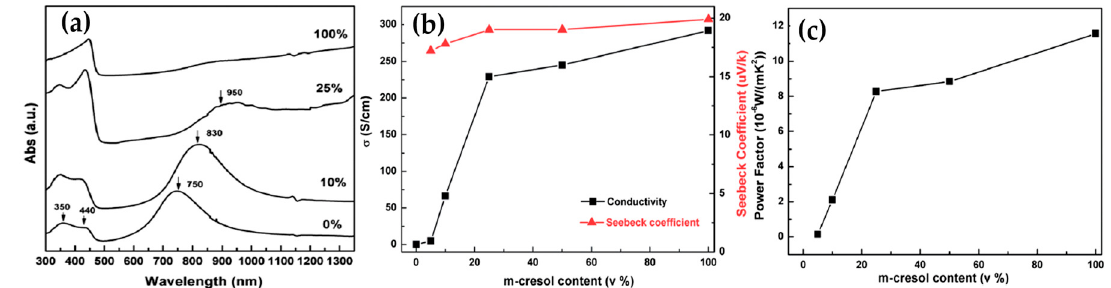
Figure 1. ( a ) The ultraviolet ‐ visible (UV ‐ vis) spectra of polyaniline (PANi) dissolved in different m ‐ cresol contents, ( b ) the electrical conductivity and Seebeck coefficient, and ( c ) the power factor of the polyaniline films prepared with different m ‐ cresol contents. Reprinted with permission from [28]. Copyright 2014 The Royal Society of Chemistry.